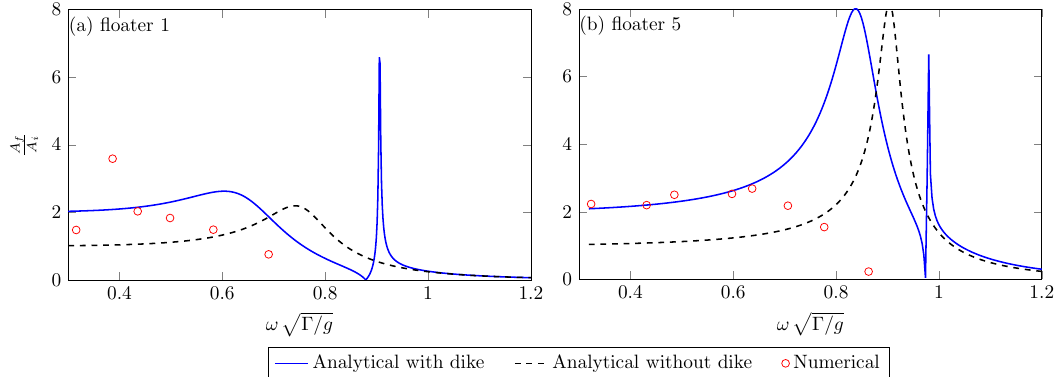
Figure 5. Impact of the dike on floater motion for h = 0.6 m, a i = 0.025 m, D = 0.01 m and floaters 1 and 5: ( a ) D / Γ = 0.2; ( b ) D / Γ =